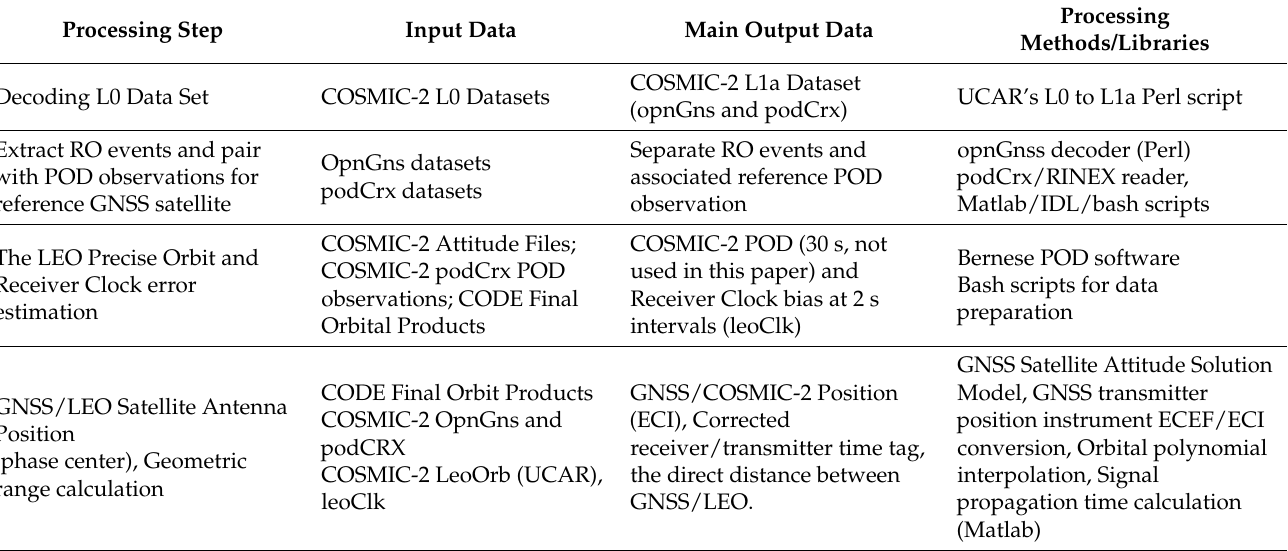
Table 1. STAR implementation of the RO processing chain.